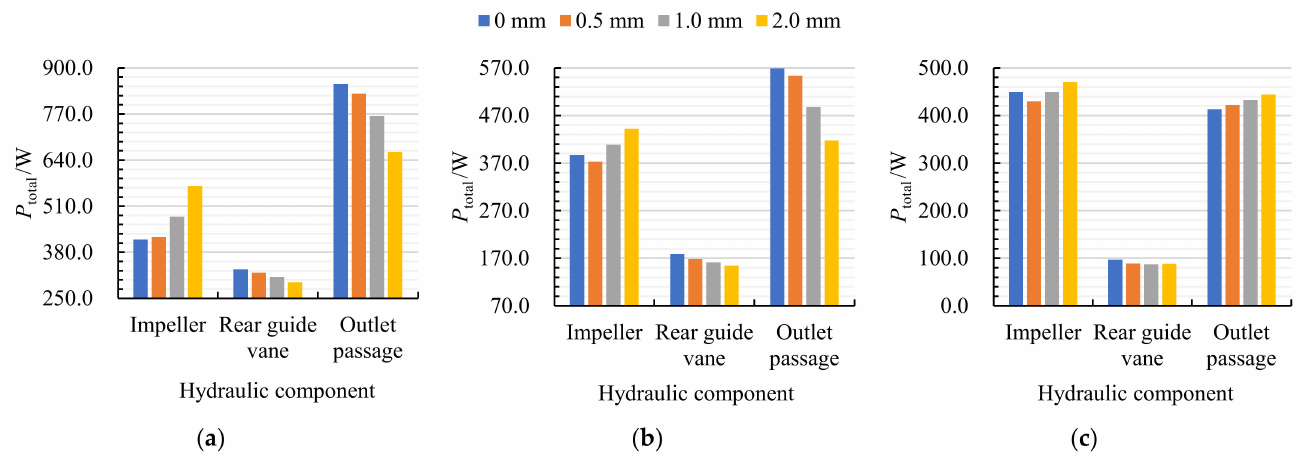
Figure 8. Total dissipation of hydraulic component under different R b at ( a ) 0.8 Q des , ( b ) 1.0 Q des , and ( c ) 1.2 Q des .